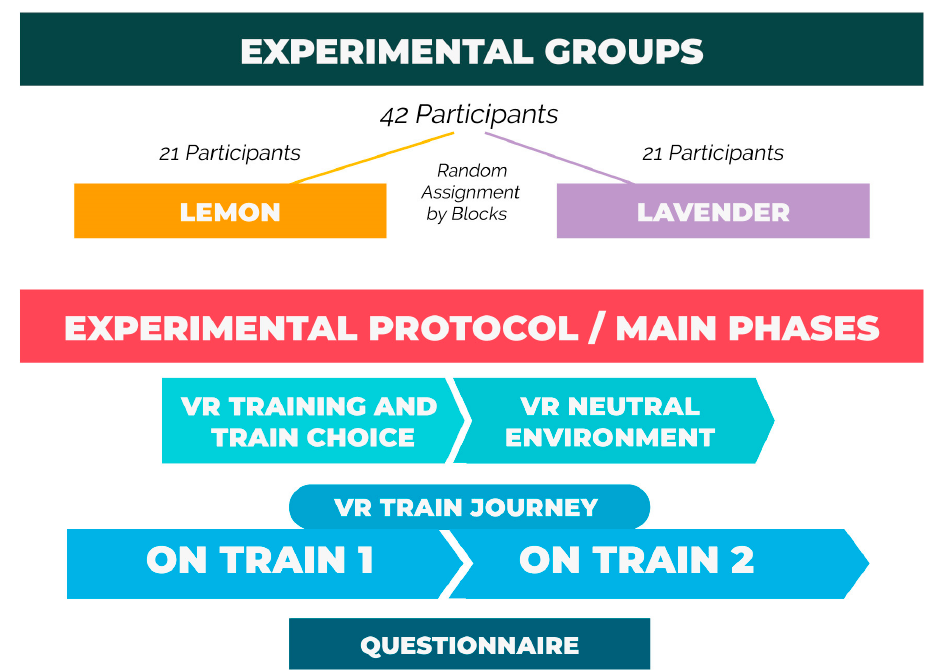
Figure 1. Distribution of participants across the two conditions “lemon” and “lavender”, and the four main phases of the experimental protocol: “VR training and train choice”, “VR neutral environment (baseline)”, “VR train journey” (on train 1 and train 2), and “Questionnaire”.